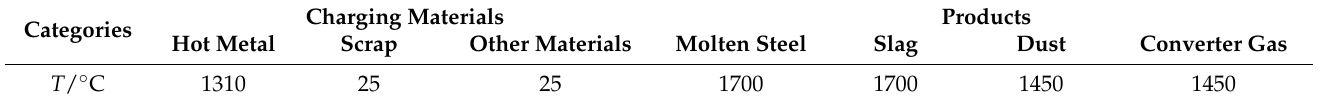
Table 2. Temperatures of charging materials and products.